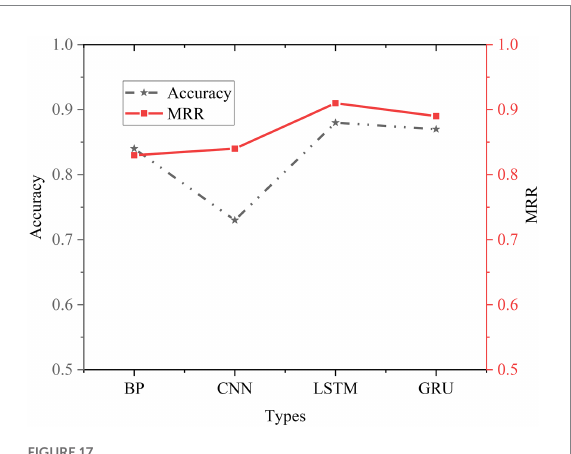
FIGURE 17 Comparison of experimental results of basic